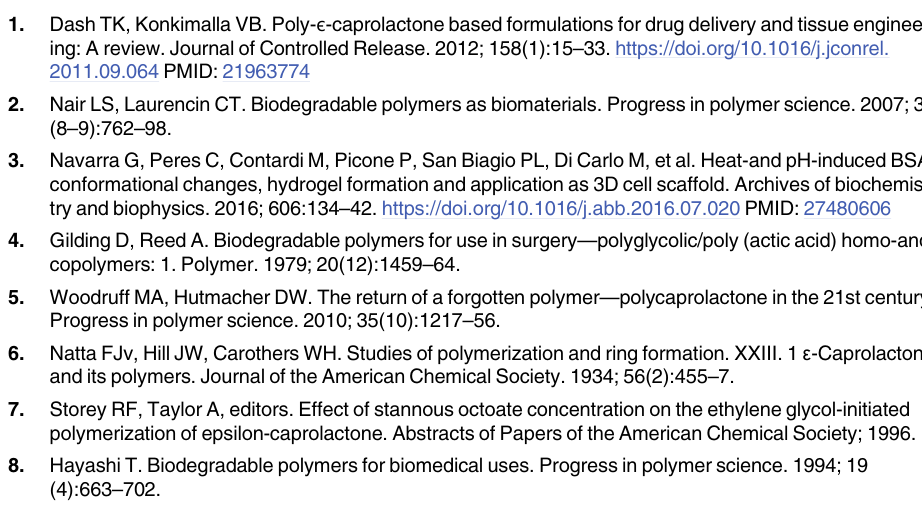
S3 Fig. Inhibition zone assay. Antibacterial effect of PCL-PCA films. E . coli growth in